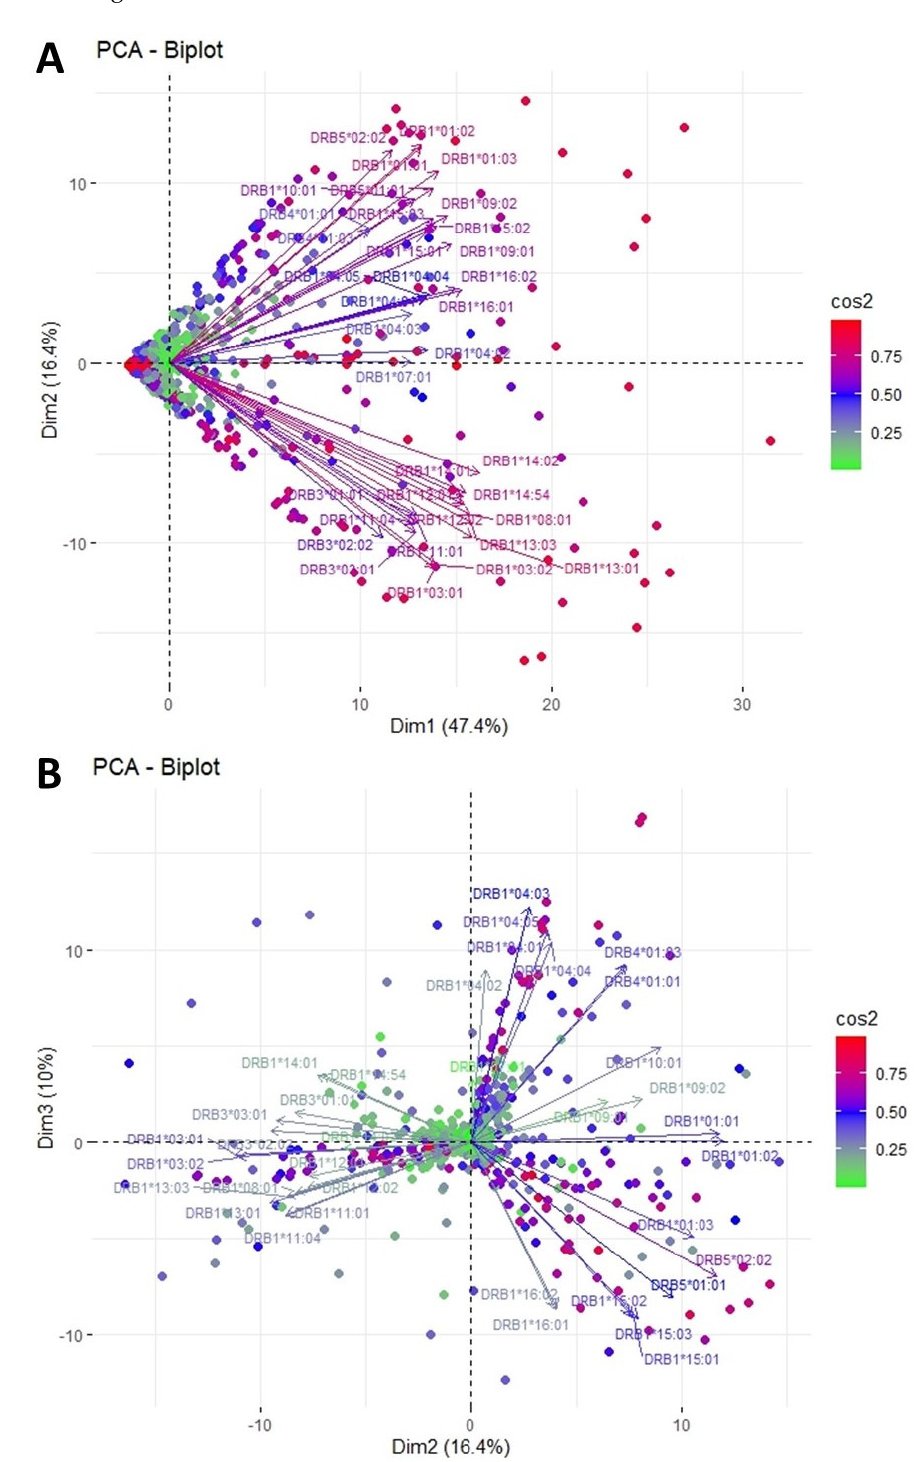
Figure 1. PCA biplot projections of anti-HLA-DR responses. ( A ) Projection of the first and second eigenvectors of the covariance matrix. ( B ) Projection of the second and third eigenvectors of the covariance matrix. Each arrow represents a specific anti-HLA-DR reaction, while each point indicates individual reactions. Colors of loadings and points represent the cos2 value of the explained variance for variables and individuals, respectively.